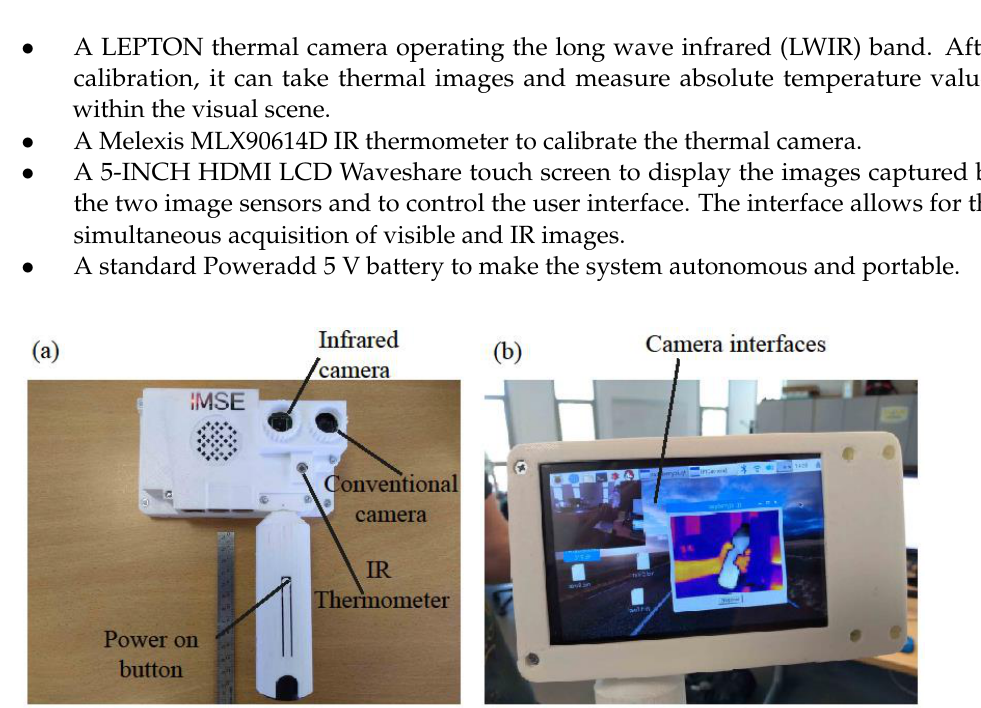
Figure 1. Details of system implementation: ( a ) front view; ( b ) back view. The system has two cameras running simultaneously. One operates in the visible spectrum and the other in the infrared band. The second camera can measure absolute temperature values after calibration. An LCD display is available to visualize data from the sensors.